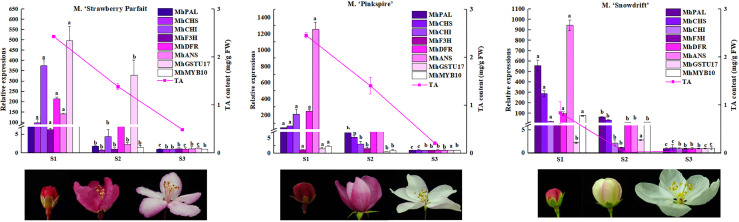
Anthocyanin contents and the key DEGs transcript levels in anthocyanin metabolism in three Malus flower in varying colors. The relative expressions of genes are exhibited as column diagram. Anthocyanin levels are indicated by lines. Correlation coefficient values between gene expression level and anthocyanin content are presented above each gene legend correspondingly. Different letters between cultivars denote significant differences (Duncan test, p < 0.05).